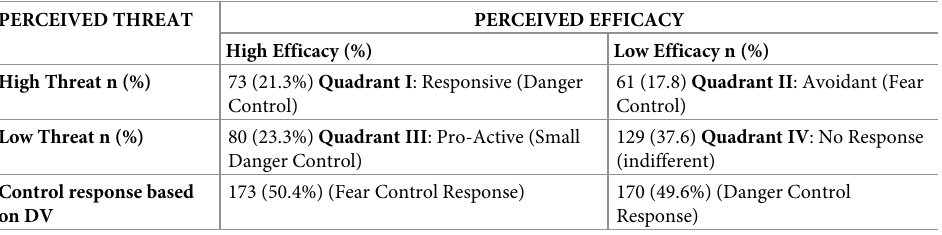
Table 4. Response to self-care message among patients with diabetes by efficacy threat interaction in Jimma Uni- versity medical center, Ethiopia April 12-May 25 2020 (n = 343).